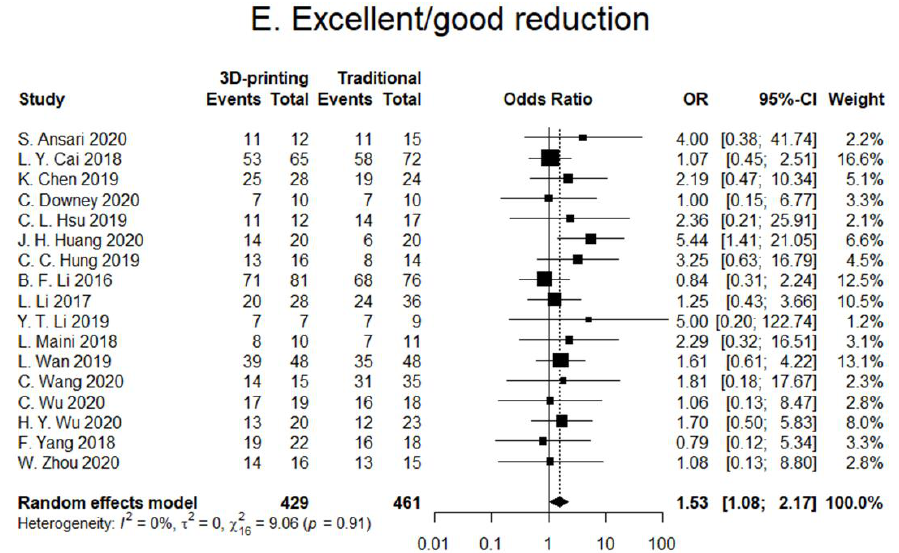
Figure 4. Forest plots of ( A ) surgical duration (minutes). Overall OR (95% CI) = 0.74 (0.66, 0.83); ( B ) amount of blood loss (mL). Overall OR (95% CI) = 0.71 (0.63, 0.81); ( C ) times of intraoperative imag- ing. Overall OR (95% CI) = 0.36 (0.17, 0.76); ( D ) number of complications. Overall OR (95% CI) = 0.42 (0.22, 0.78); ( E ) excellent/good reduction. Overall OR (95% CI) = 1.53 (1.08, 2.17). The heterogeneity was listed in the respective figures.